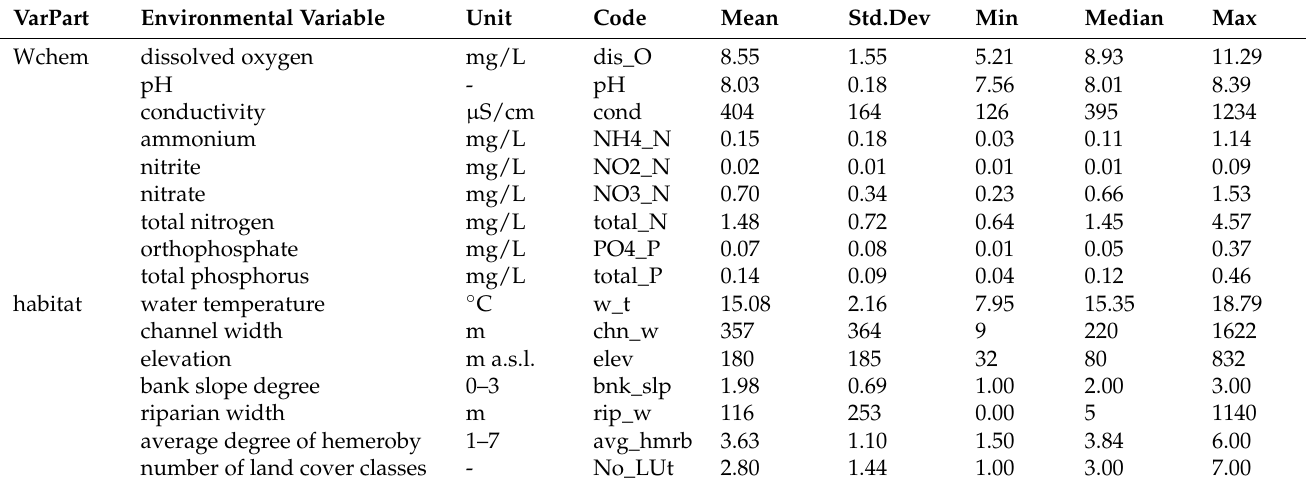
Table 1. Environmental variables used in data analyses, with the grouping applied in the Variation Partitioning (VarPart) procedure: Wchem—water chemistry; habitat—river habitat parameters.